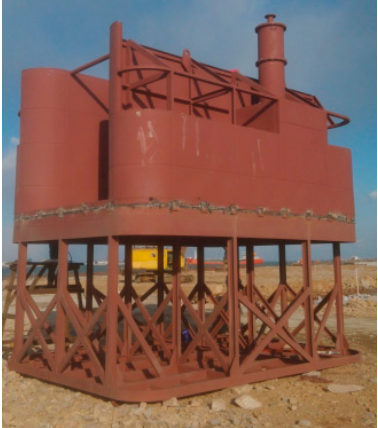
Figure 3. Engineering model.